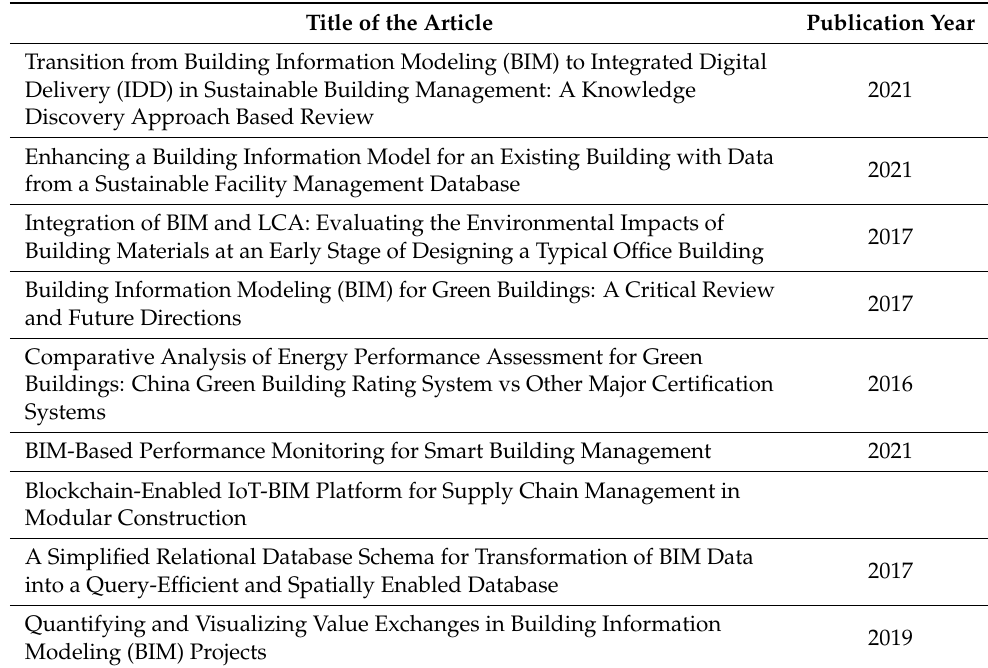
Table A3. Reviewed studies in Section 3.2.3 (sorted by order of